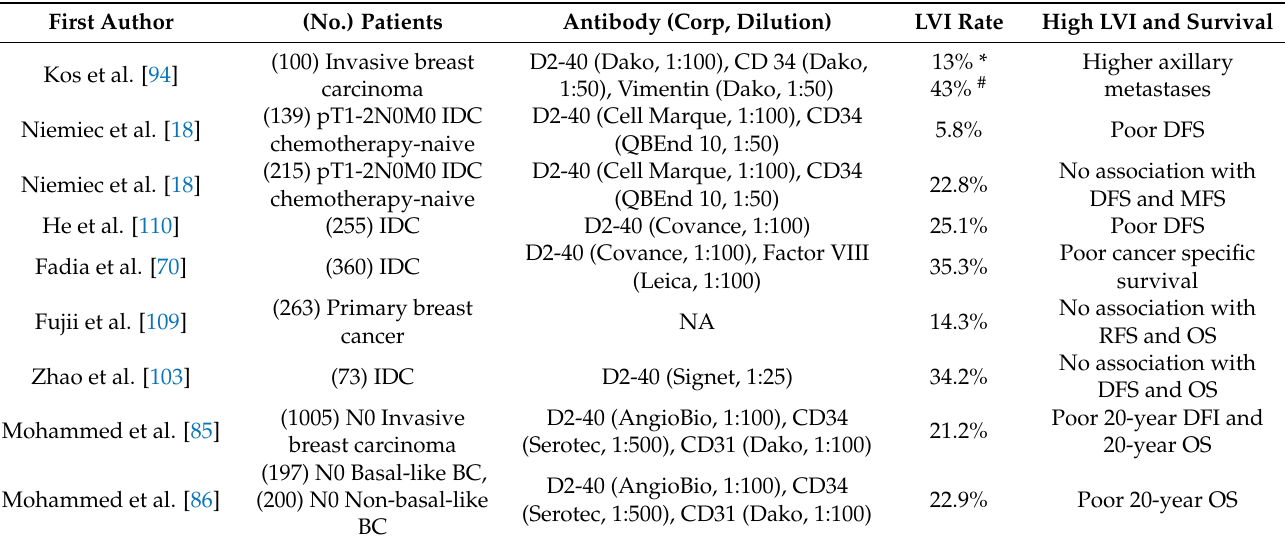
Table 3. Studies on the relationship between the lymphatic vessel invasion (LVI) and breast cancer survival over the last